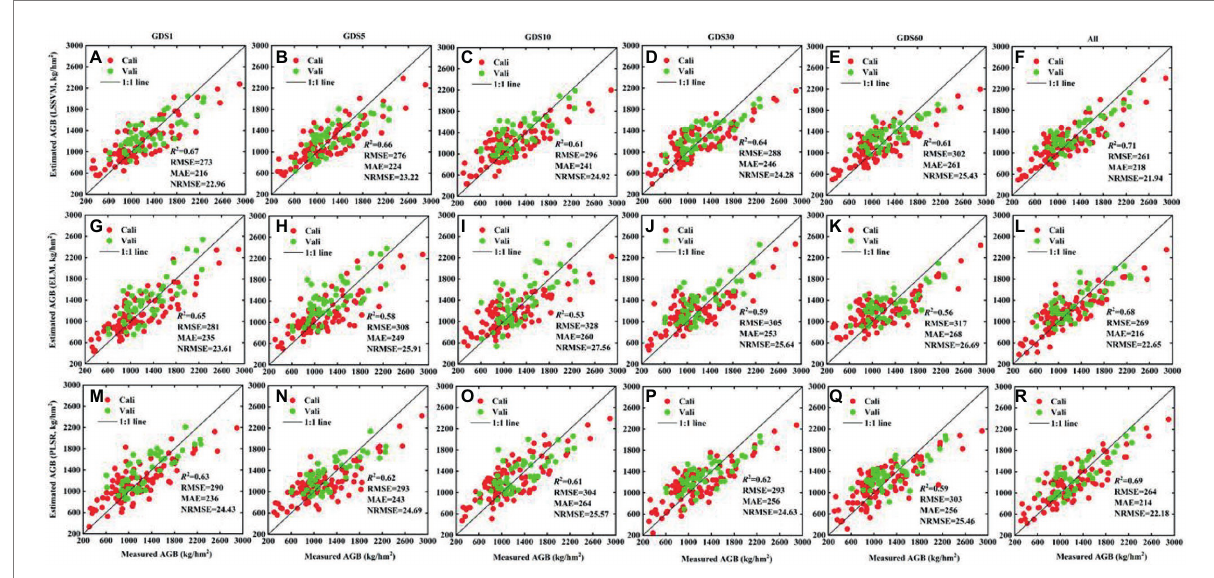
FIGURE 9 The fitted scatter plot of measuring and estimating potato AGB (kg/hm 2 ) using GLCM-based textures from GDS1, GDS5, GDS10, GDS30, GDS60 and all, respectively. (A–F) LSSVM; (G–L) ELM; (M–R) PLSR. “All” represent texture combinations of different ground resolutions. Cali and Vali represent calibration (repeat 2 and 3) and validation data sets (repeat 1), respectively. The estimation results of Cali and Vali are shown in Supplementary Table A1.